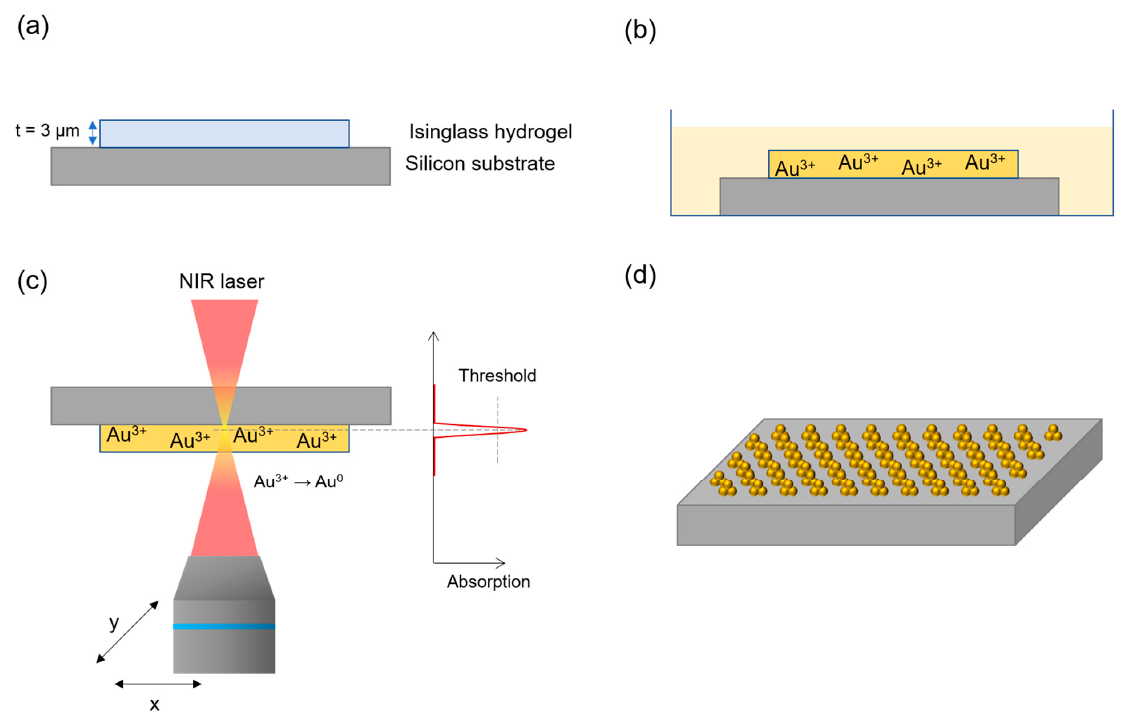
Figure 1. Scheme depicting the nanofabrication of AuNSs via TPA–DLW process: ( a ) a hydrogel layer is deposited on the top of a silicon substrate; ( b ) immersion of the hydrogel film in a HAuCl 4 solution for 30 min to allow Au 3+ diffusion into the hydrogel matrix; ( c ) photoreduction of Au 3+ into Au 0 via TPA–DLW using an NIR laser, taking advantage of the TPA process; ( d ) a washing step with deionized water stops the created AuNSs growth; a second washing step with warm water removes the hydrogel film, leaving the AuNSs attached to the silicon substrate.